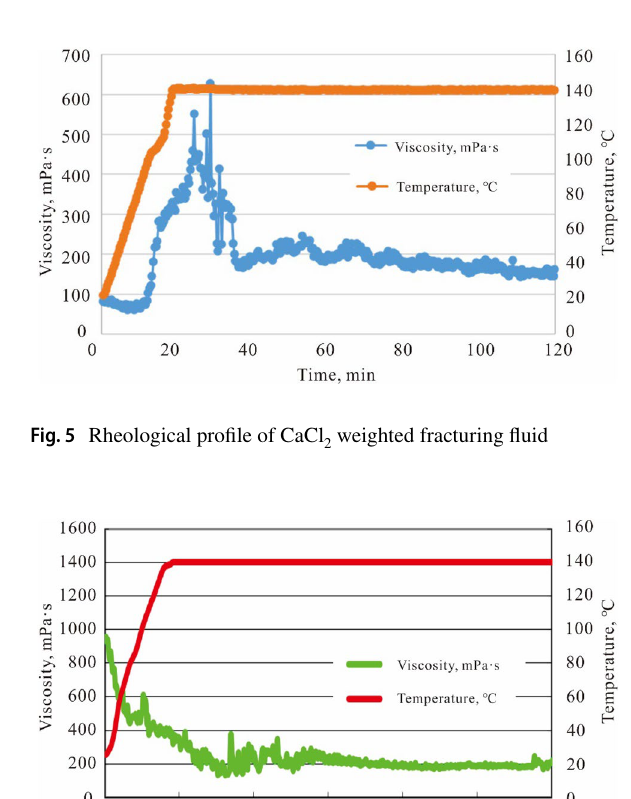
Fig. 6 Rheological profile of KCl weighted fracturing fluid